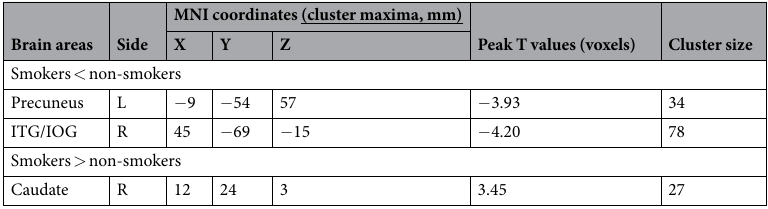
Table 2. Brain areas with altered fALFF between smokers and nonsmokers. The result threshold was at P < 0.005, and only clusters exceeding a size of 27 voxels are reported. All coordinates are given in Montreal